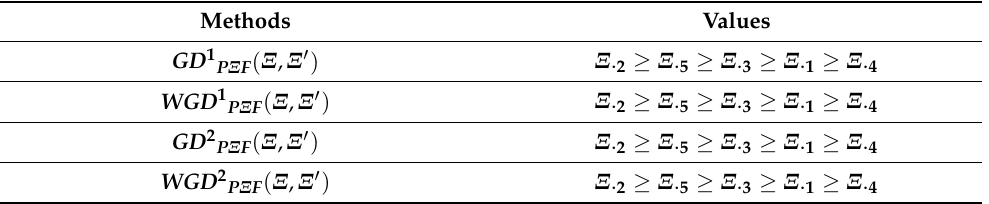
Table 2. Contained ranking analysis of the information in Table 1.